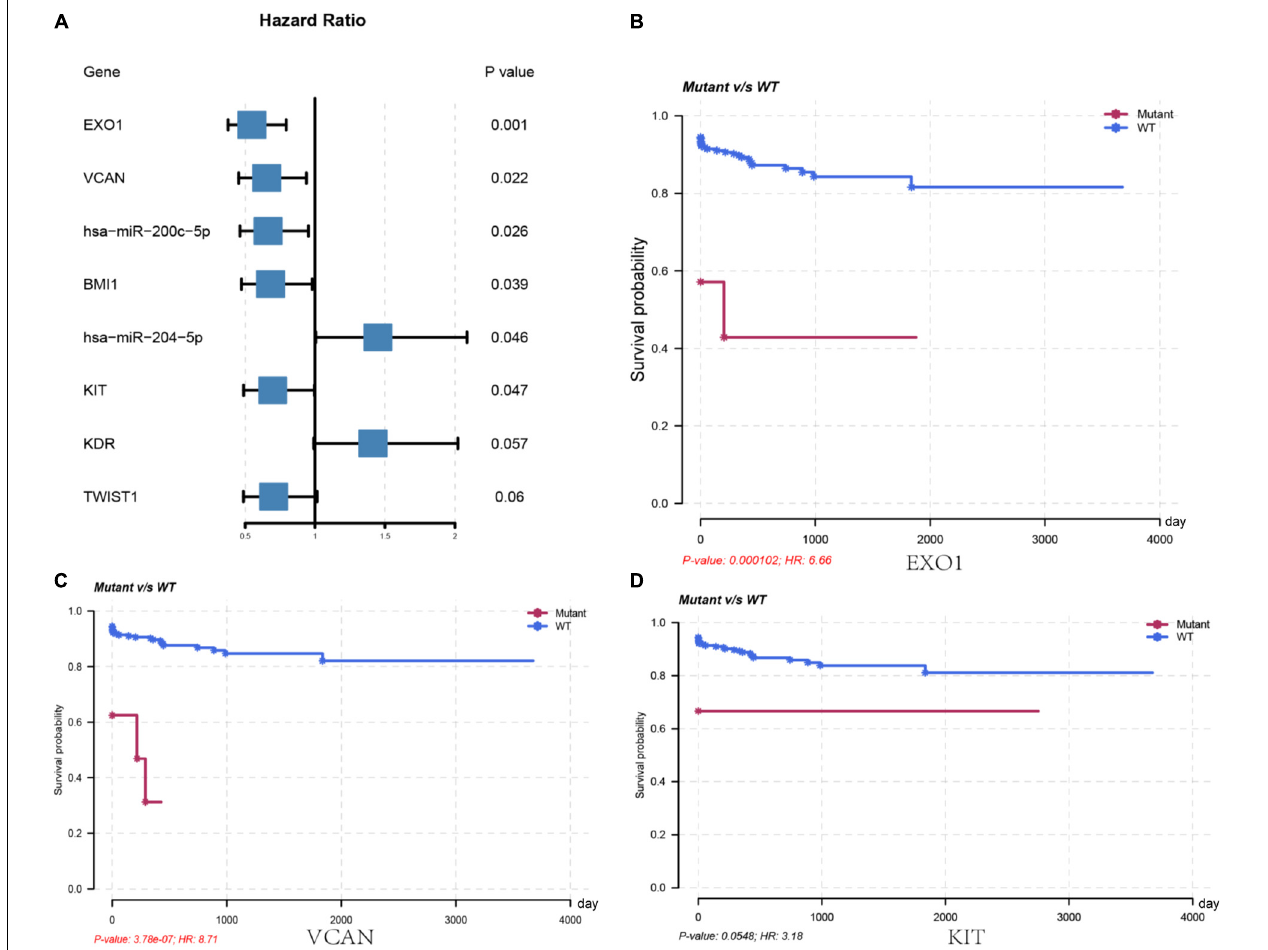
FIGURE 5 | Key regulators are related to worse survival rate. (A) Forest plot of hazard ratios showing the prognostic values of genes. (B–D) Survival curves of key regulators in the LIHC patients from TCGA dataset. LIHC, liver hepatocellular carcinoma; TCGA, The Cancer Genome